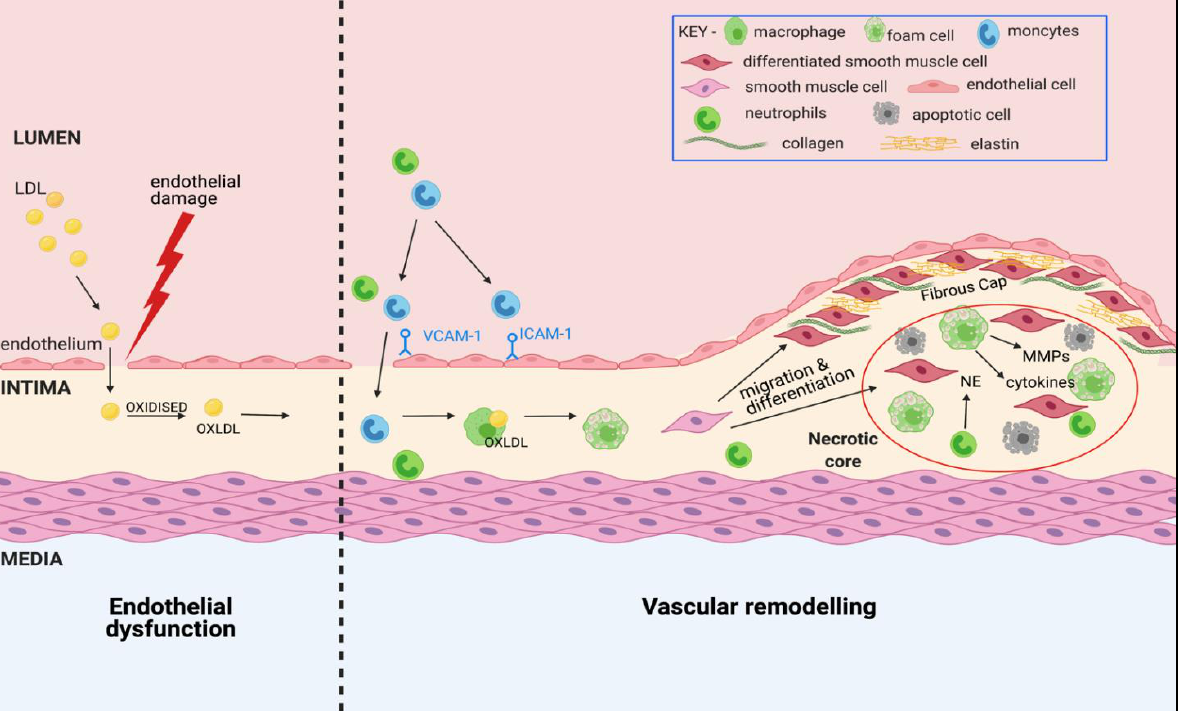
Figure 1. Pathogenesis of atherosclerotic lesions with features of vulnerability. In response to damage to the endothelium, circulating LDL-cholesterol infiltrates the intimal layer and becomes oxidised by free radicals into oxidised LDL (oxLDL), triggering an inflammatory cascade in which immune cells (including monocytes and neutrophils) are recruited from the circulation by attachment to adhesion molecules (VCAM-1 and ICAM-1) on the surface of the endothelium. Infiltrated monocytes differentiate into pro-inflammatory macrophages and ingest oxLDL, forming foam cells. Smooth muscle cells migrate from the medial layer and differentiate to form a fibrous cap containing collagen and elastin. Proteases including matrix metalloproteinases (MMPs) and neutrophil elastase (NE) are released from immune cells, resulting in degradation of the extracellular matrix, facilitating vascular remodelling and enhancing the pro-inflammatory mileu. The accumulation of foam cells, apoptotic/necrotic cells and migrated smooth muscle cells forms a necrotic core, which upon rupture is highly thrombotic .